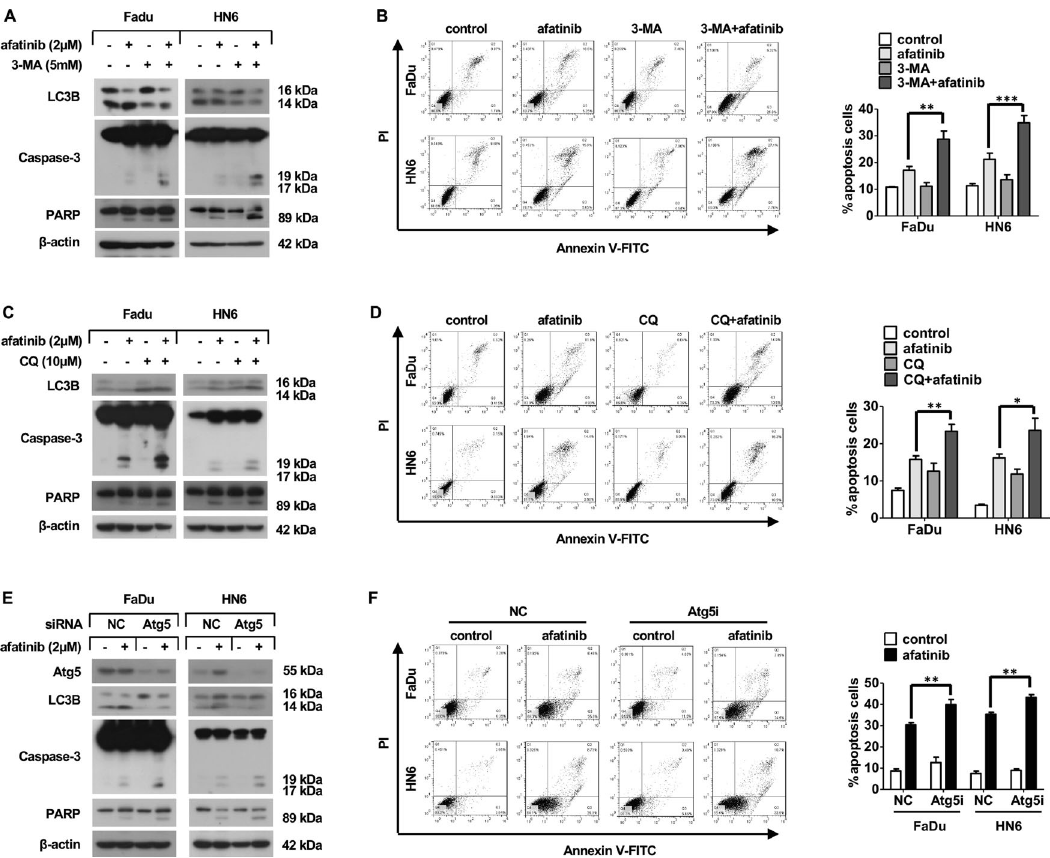
Fig. 5 Afatinib-triggered autophagy plays a protective role in HNSCC. A – D FaDu and HN6 cells were pretreated with 5 mM 3-MA for 2 h ( A , B ) or with 10 μ M CQ for 30 min ( C , D ) followed by co-treatment with 2 μ M afatinib for another 24 h. The level of LC3B and apoptosis-associated proteins caspase-3 and PARP was measured by western blot analysis ( A , C ), while fl ow cytometry analysis was carried out to evaluate apoptosis ( B , D ). E , F FaDu and HN6 cells were transfected with control and Atg5 siRNA. Forty-eight hours after transfection, cells were exposed to 2 μ M afatinib for 24 h. Atg5, LC3B, and apoptosis-associated proteins caspase-3 and PARP were measured by western blot analysis ( E ), meanwhile fl ow cytometry analysis was carried out to evaluate apoptosis ( F ). All data are presented as mean ± SD from three independent experiments. * p < 0.05, ** p < 0.01, *** p <